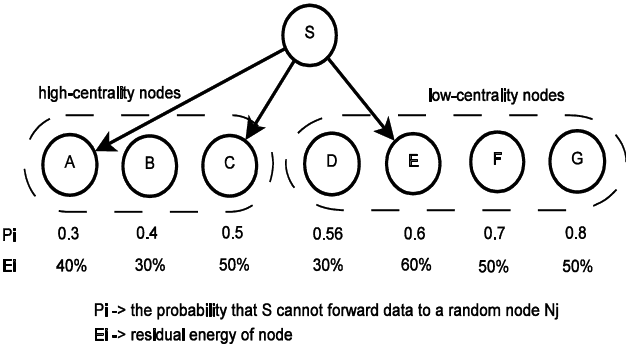
Figure 11. Relay selection in the EASDM scheme Figure 11 . Relay selection in the EASDM scheme [59].